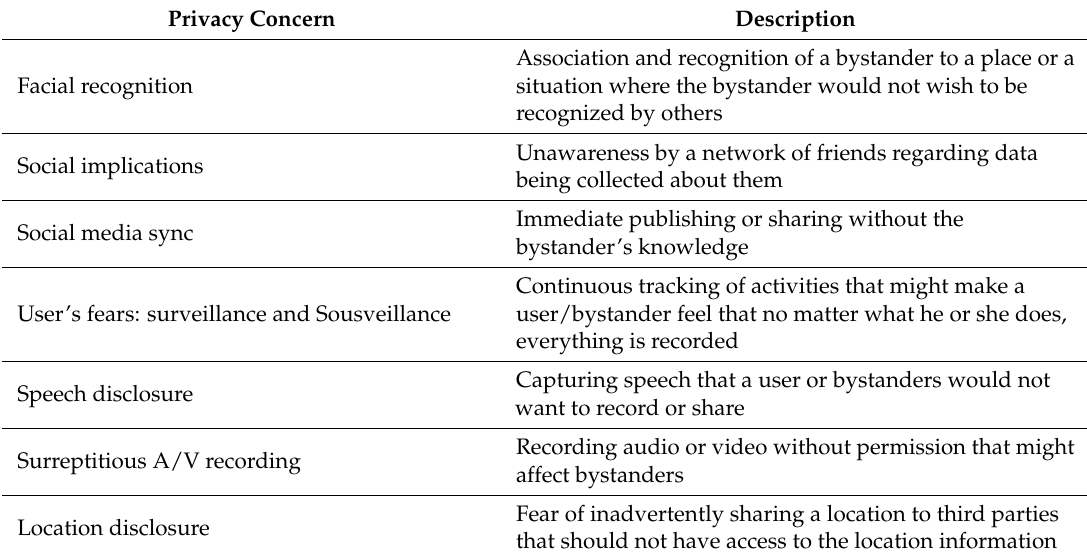
Table 1. Bystanders’ privacy concerns adapted from Motti et al.